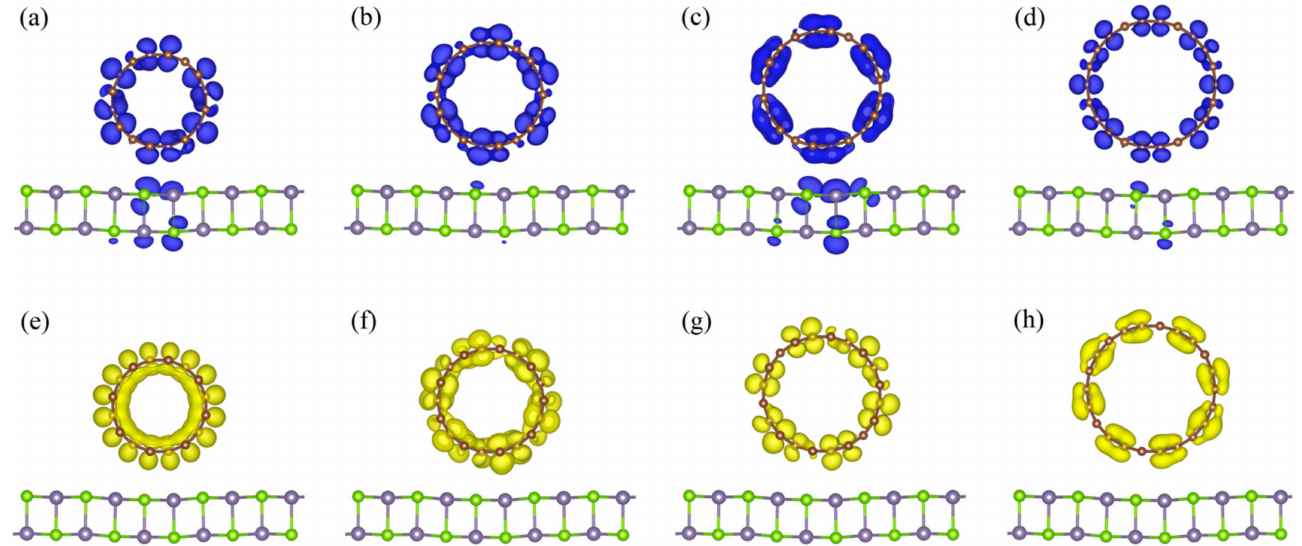
Figure 6. Maps of the hole and electron density distributions for ( a – d ) VBM and ( e – h ) CBM of CNT(8,0)/GeSe, CNT(9,0)/GeSe, CNT(10,0)/GeSe, and CNT(11,0)/GeSe with an isovalue of 0.007 e/Å 3 , respectively. Blue and yellow regions denote the hole and electron density distributions of the VBM and CBM, respectively. Brown, cyan, and purple spheres represent C, Se, and Ge atoms,